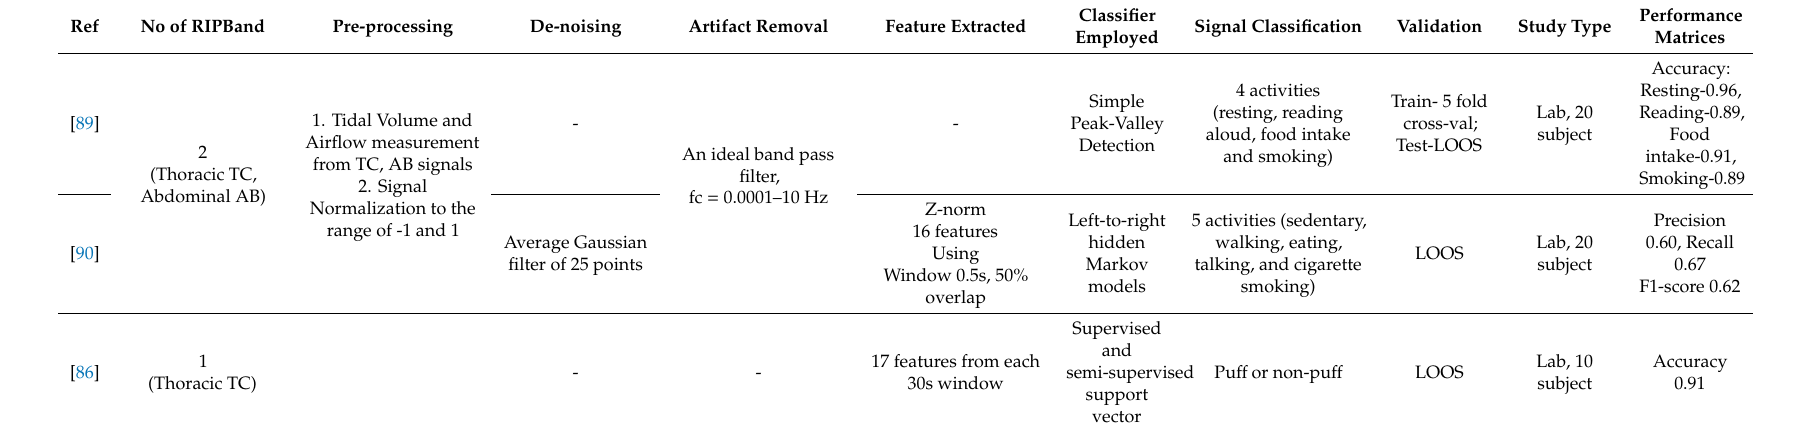
Table 10. A summary of detection algorithms employed on RIP